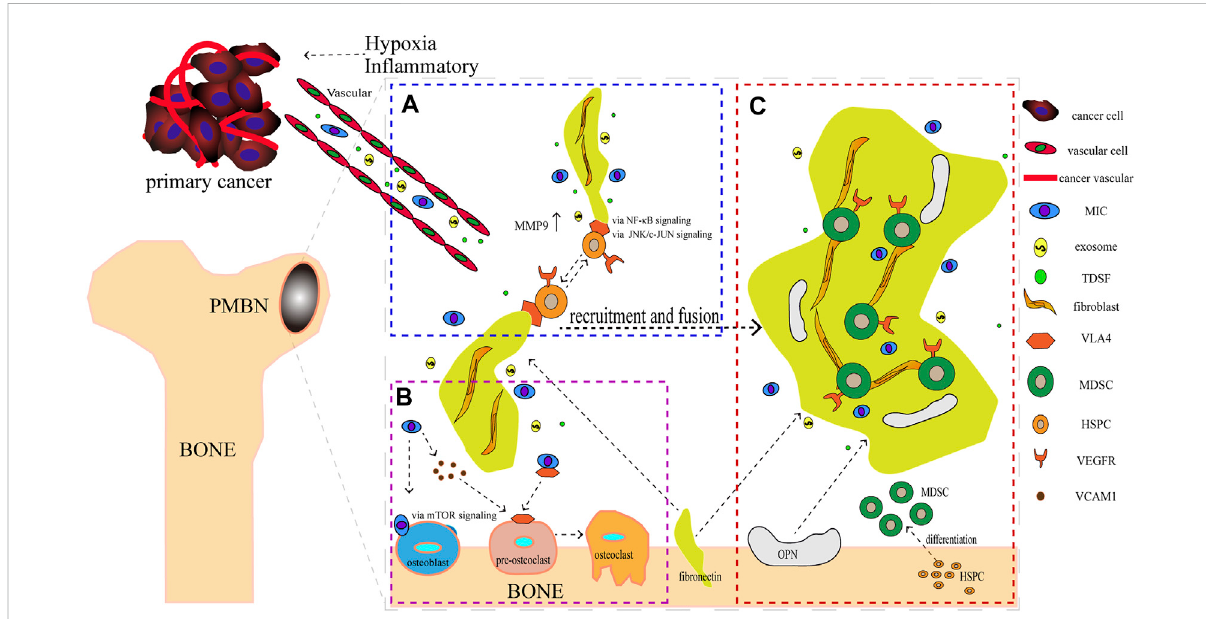
FIGURE 1 The formation of the Pre-Metastatic Bone Niche (PMBN). (A) Metastasis-initiating cells (MICs), exosomes, and tumor-derived soluble factors (TDSF) were secreted by cancer cells under hypoxia and in fl ammatory conditions. Fibronectin carried by VEGFR + HSPC, which was connected by integrin alpha4 beta1 (VLA4), were recruited together. (B) Before bone metastasis, the balance of osteoblast and osteoclast is disrupted. MICs can adhere to osteoblasts and recruit pre-osteoclasts via vascular cell adhesion protein 1 mediated by mTOR signaling. This event promotes the formation of osteoclasts. (C) Maturation of PMBN. Notably, HSPC was differentiated into MDSC. The difference of source and function of components differ between PMN and